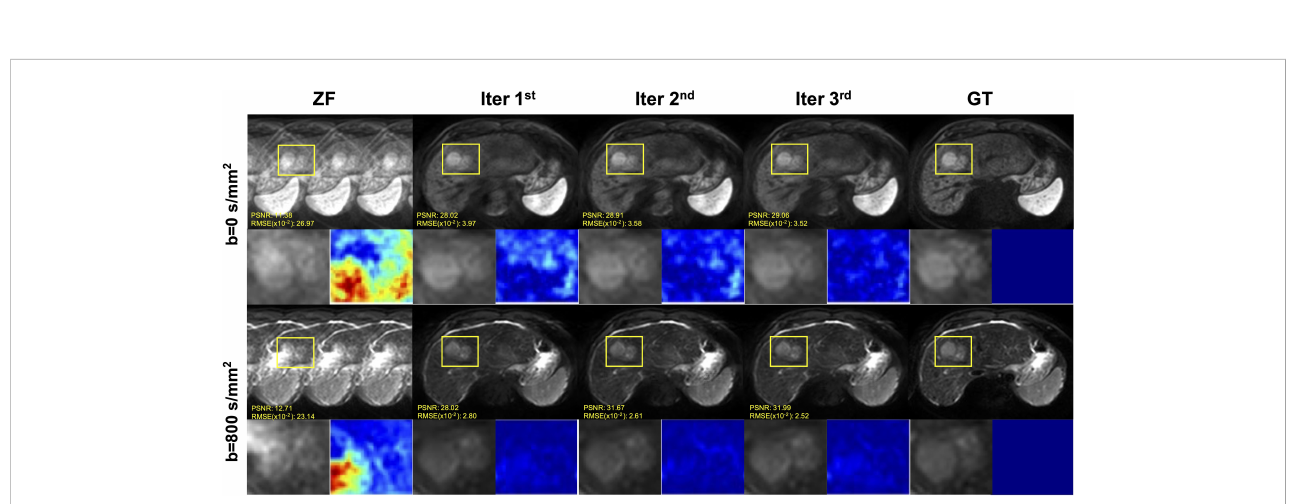
FIGURE 5 The iterative iMCGAN reconstruction with the tumor at the AF of 4. The PSNR and RMSE values are shown in the corner. For a fair visual comparison, the images were normalized to [0, 1]. The enlarged and different images with the tumor are illustrated with the